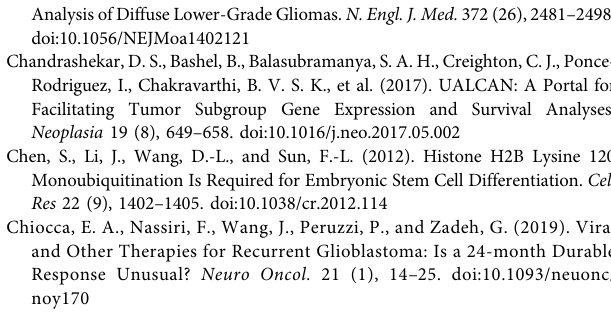
Supplementary Figure S1 | The expression and clinicalvalue ofH2BC12 mRNA in GII and GIII gliomas tissues. H2BC12 showed signi fi cantly higher expression in GIII tissue than in GII tissue (A) , p < 0.05 and was related to IDH status (B) , p < 0.05. (C) ROC analysis of H2BC12 in classi fi cation power for GII and GIII (AUC=0.706). Supplementary Figure S2 | H2BC12 promoter methylation level and mutation analysis. (A – D) The level of DNA methylation in the H2BC12 promoter region in patients with TP53 mutant status, age, gender, and race. (E) H2BC12 mutation in most brain tumors. ns: P > 0.05; *P <